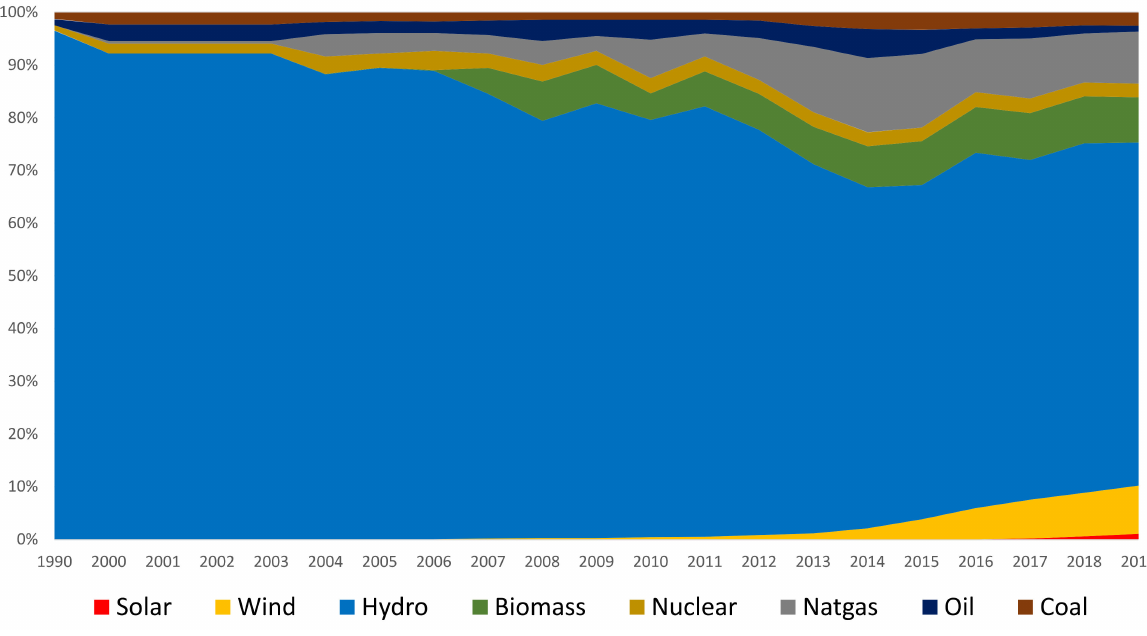
Figure 3. Brazilian electricity generation—percentage composition